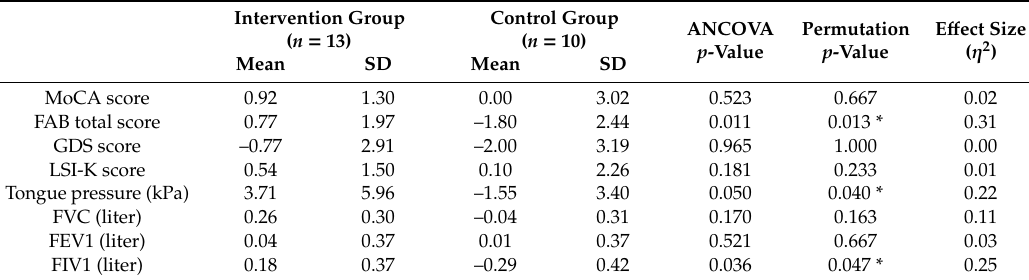
Table 2. Comparison of score changes after